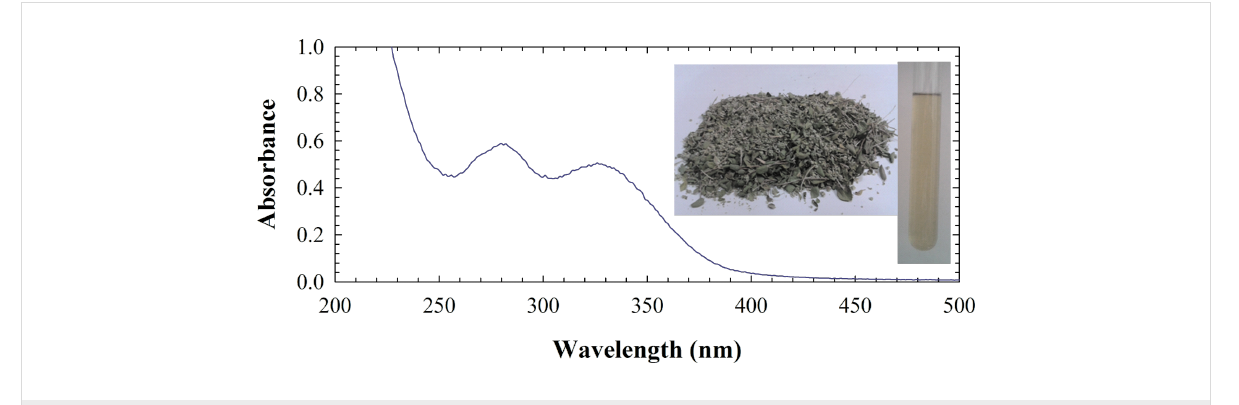
Figure 1: UV–vis spectrum of an aqueous extract of Thymus vulgaris .